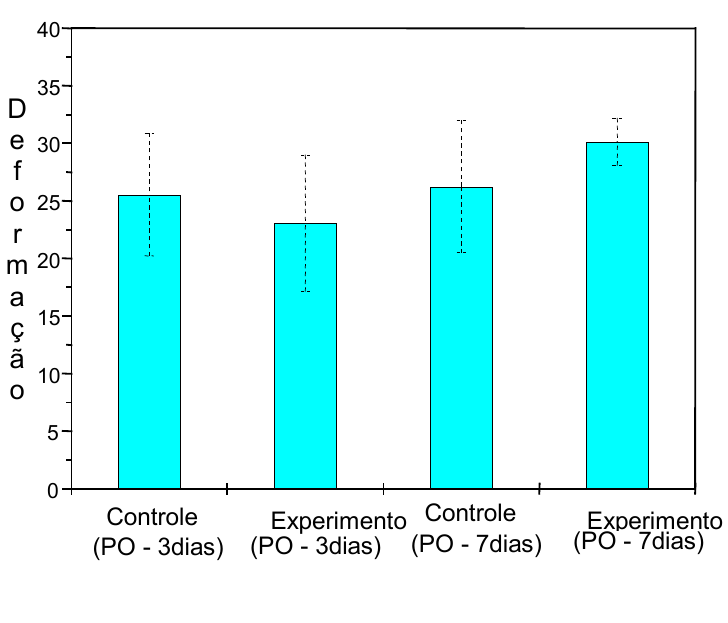
FIGURA 18 – Deformação máxima